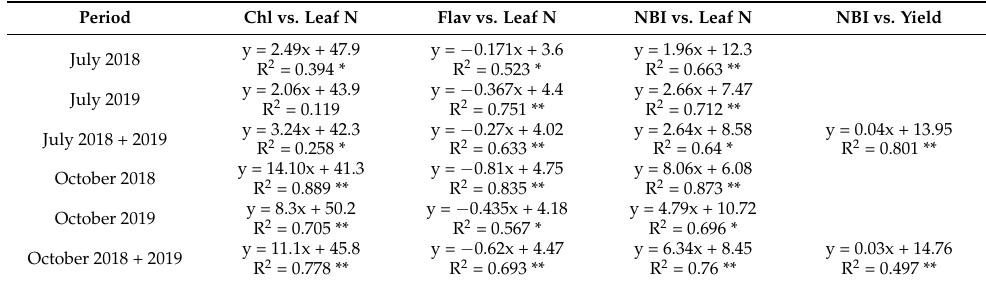
Figure 2. The relationship between chlorophyll (Chl), flavonols (Flav) and NBI optical indices and the nitrogen content in cabbage leaves in 2018: July ( A ) at 39 DAT, October ( B ) at 136 DAT and 2019: July ( C ) at 49 DAT, October ( D ) at 126 DAT. Table 2. Equations and R 2 of the regressions between Chl, Flav, NBI indices and the leaf N content and between NBI and total cabbage yield.